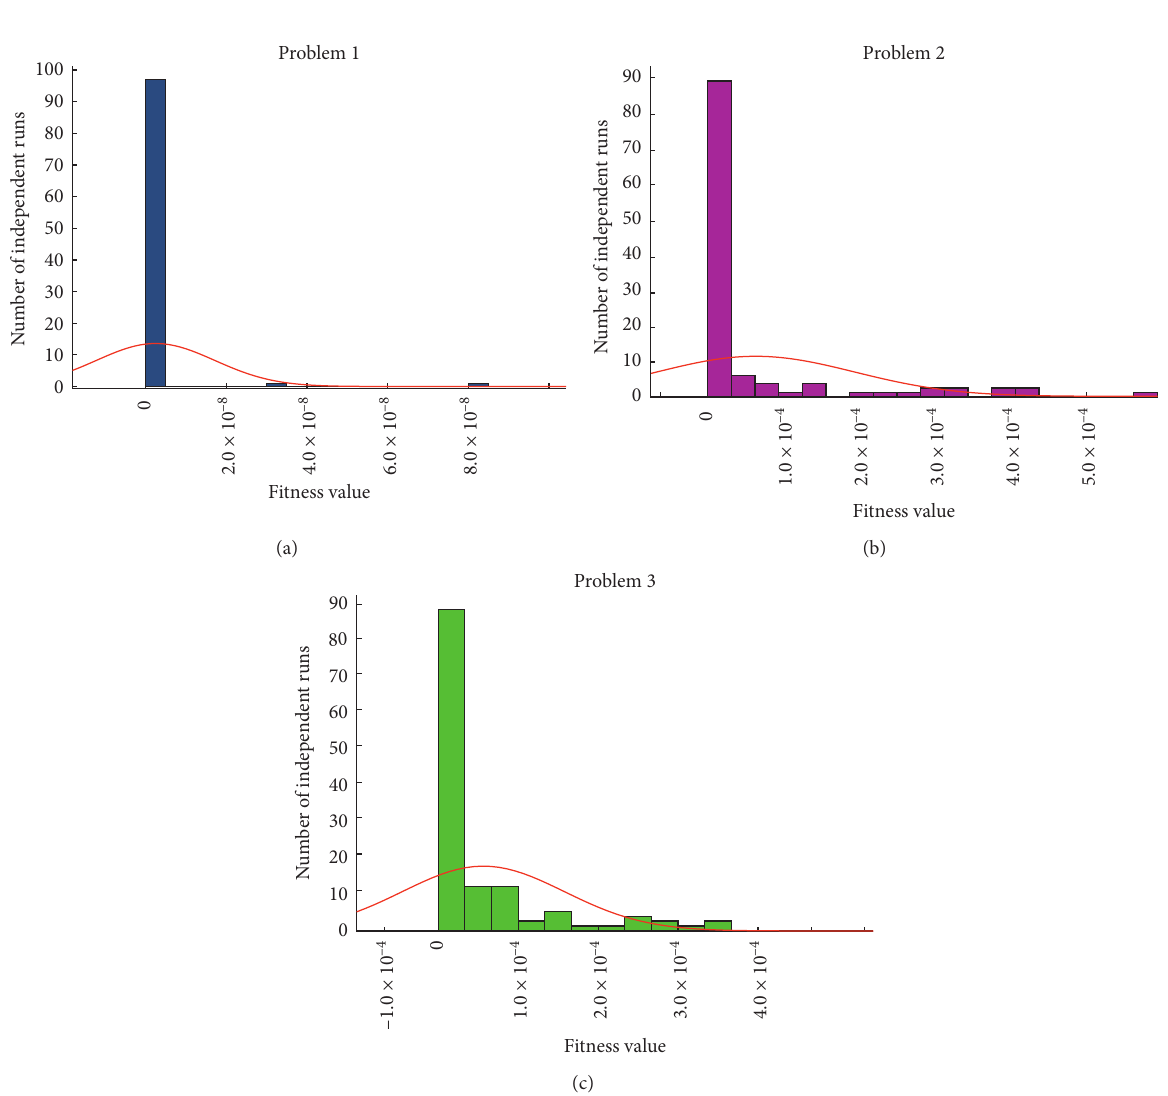
Figure 7: Normal probability plots of fitness values obtained during 100 experiments for Problems 1–3. Problem 1